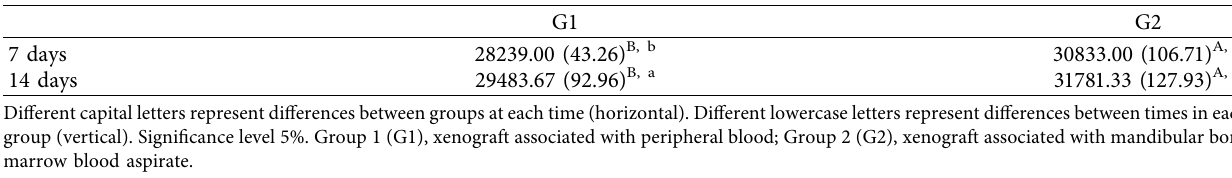
Table 1: Mean scintigraphic analysis of the groups evaluated at the different analysis times, in pixels.